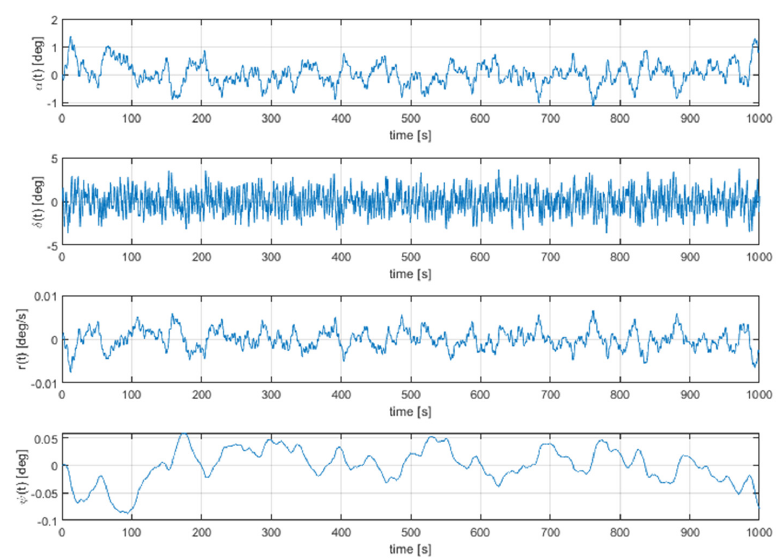
Figure 5. Responses of the heading angle under the influence of the disturbance.